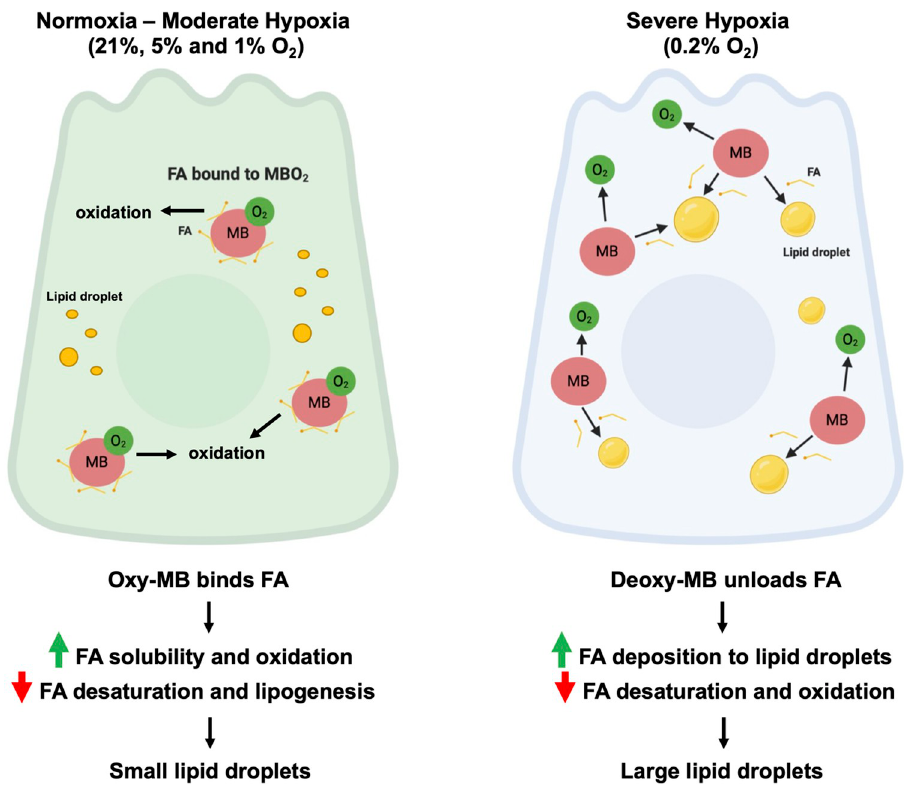
Fig 6. Model. Schematic diagram of MB’s role as an O 2 -dependent shuttle of FAs in mammary epithelial cells. Under normoxia and moderate hypoxia (left panel), oxygenated MB (MBO 2 ) binds C16/C18 FAs and promotes cytoplasmic solubility and FA oxidation in association with smaller lipid droplets. Under severe hypoxia (right), MB unloads O 2 and FA and deposits FAs to lipid droplets of larger sizes, potentially to prevent ROS poisoning, lipotoxicity and to store FA substrates for energy production upon